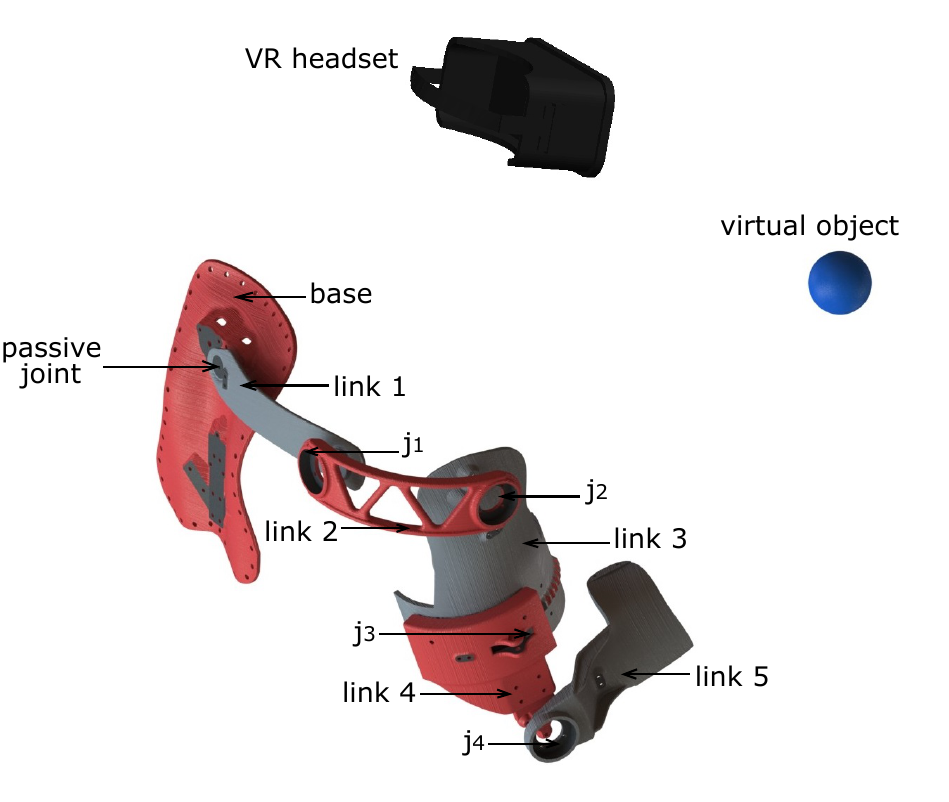
Figure 2. Description of the upper-limb exoskeleton CAD